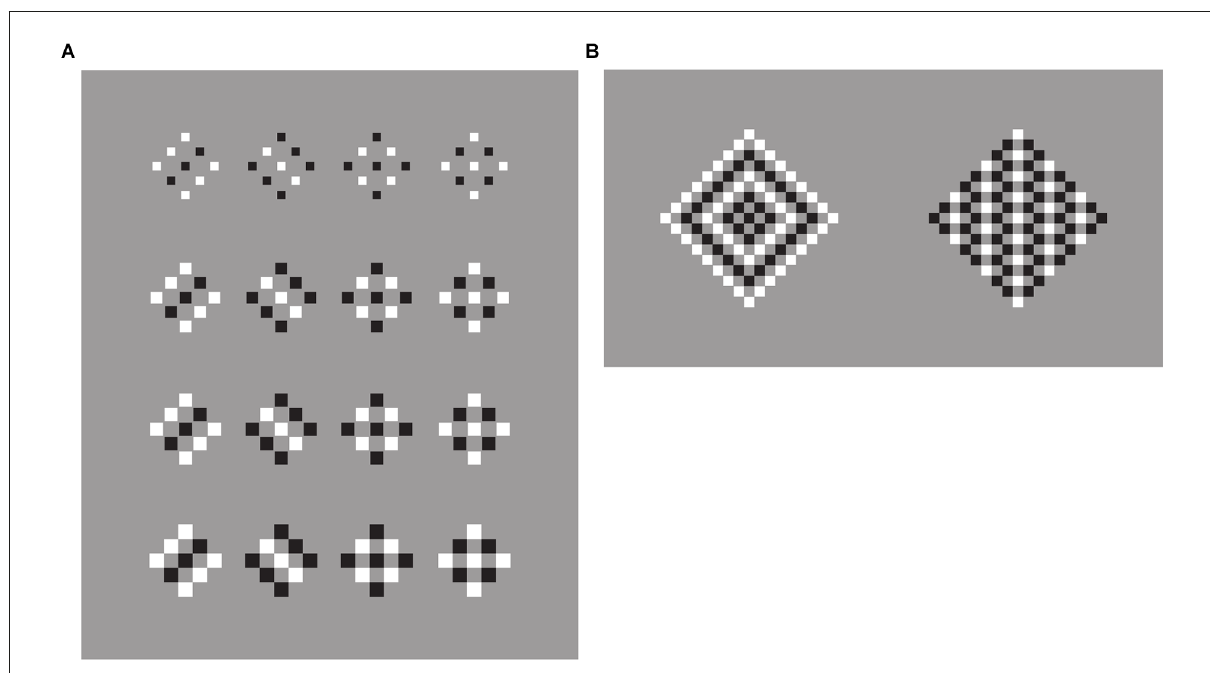
FIGURE9 (A) Diamonds on the first two columns and squares on the other two. The patterns of stimuli are all the same made of squares. (B) Diamonds (left), and squares (right) within the same patterns of stimuli made of squares.